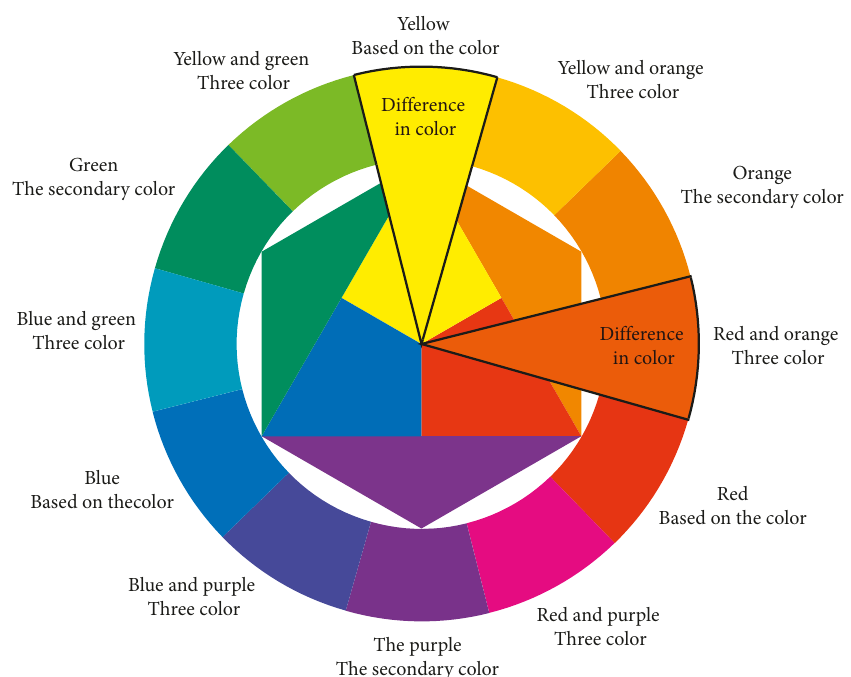
Figure 1: Dyeing and color matching standard of traditional silk